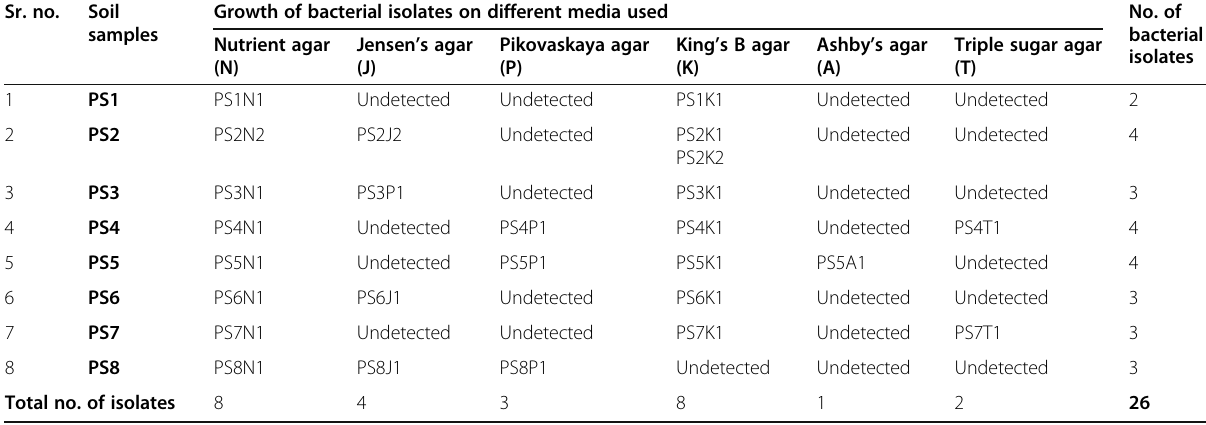
Table 3 Details of bacteria isolated from soil samples of Panipat, Haryana, India Sr. no. Soil